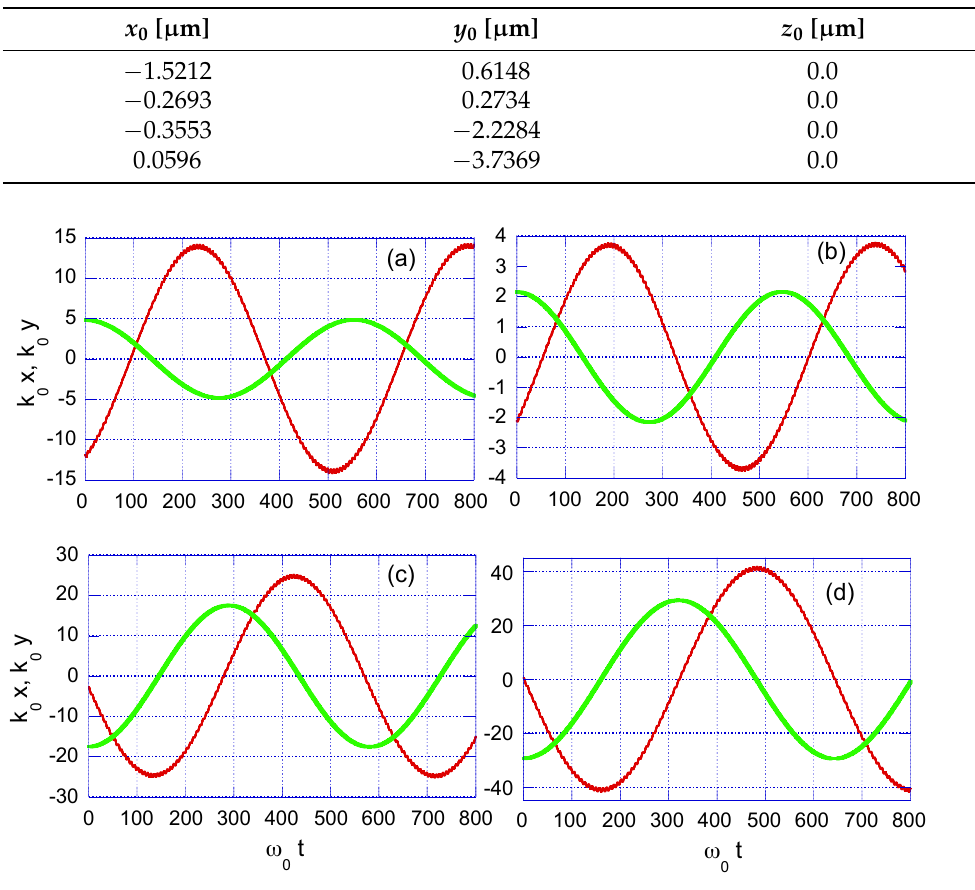
Figure 1. Temporal evolution of normalized x ( t ) (in red) and y ( t ) (in green). Abcissas and ordinates are dimensionless, being respectively the products ω 0 × t and k 0 × x ( t ) = 2 π x ( t ) / λ 0 , etc. Four cases with different initial conditions are displayed, see main text for details. Trapped solutions appear as low-frequency (as compared with the optical one) confined motions in the transverse xy -plane. Note the different relative phases and amplitudes of x ( t ) and y ( t ) depending on the initial